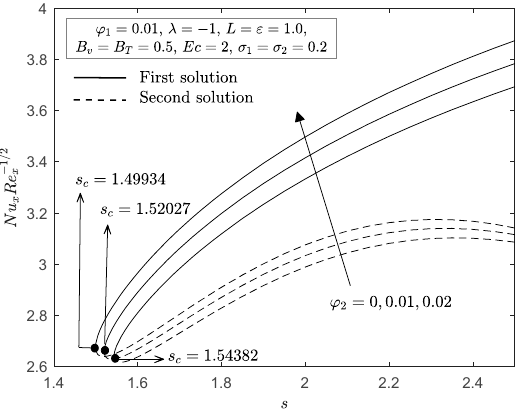
Figure 3. Figure 3. 1/2 Re